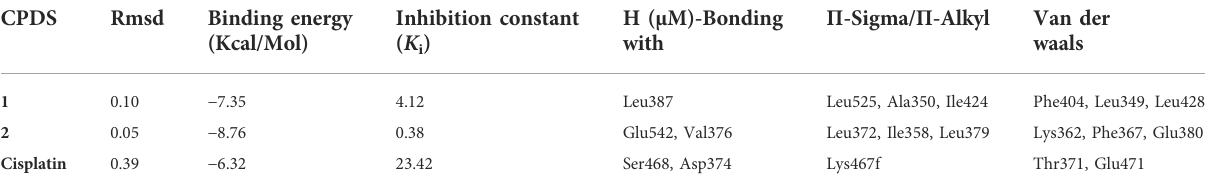
TABLE 5 Molecular docking scores and the corresponding prominent residual amino acid interactions of the complexes against estrogen receptor alpha (ER α ; PDB:5GS4). Π -Sigma/ Π -Alkyl Van der CPDS Rmsd Binding energy Inhibition constant H (µM)-Bonding (Kcal/Mol) ( K i ) with